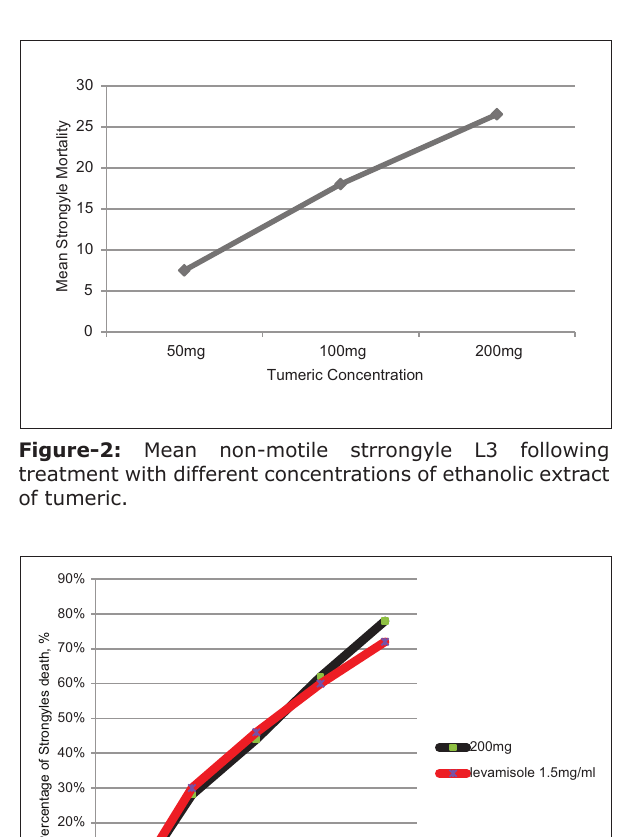
Figure-1: Percentage of larvae mortality at different hours following treatment with different concentrations of ethanolic extract of tumeric.